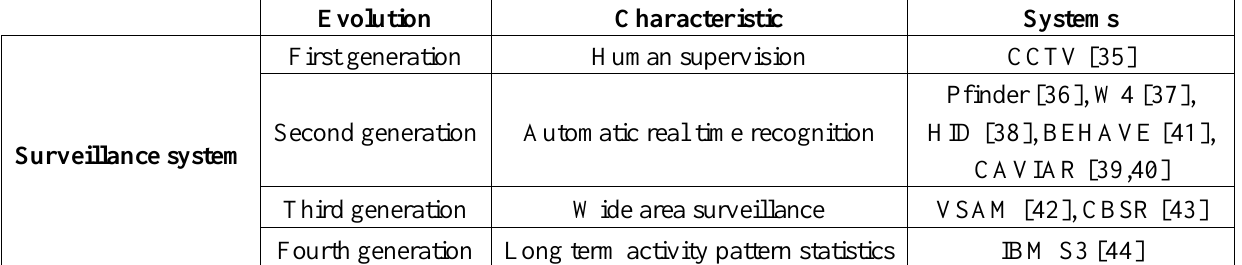
Table 2. Past surveillance systems based on activity